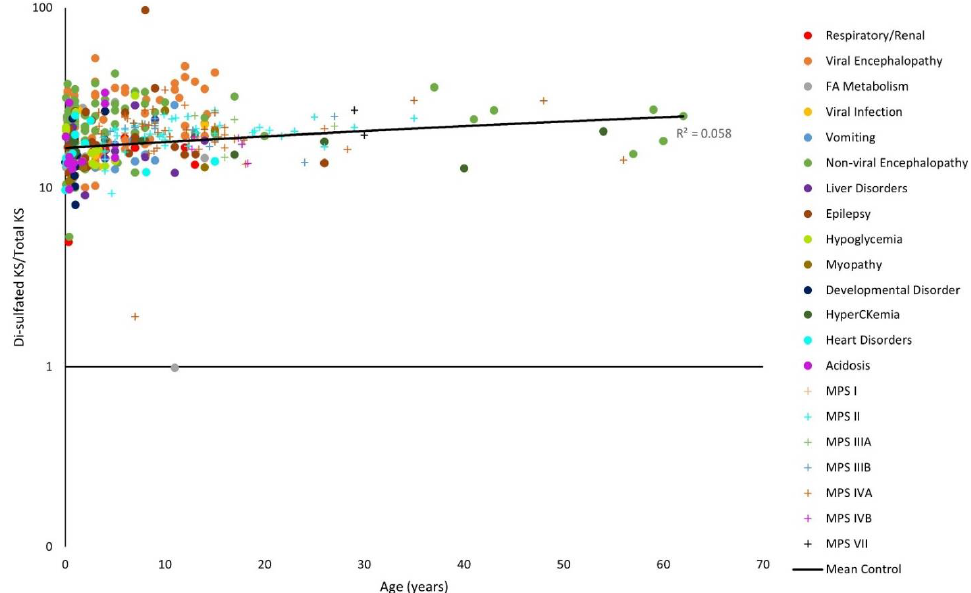
Figure 6. Ratio of di-sulfated keratan sulfate (KS) to total KS levels with age on a logarithmic scale. The linear trendline of control values is shown as a black line, and glycosaminoglycan (GAG) values for patients with mucopolysaccharidosis (MPS) are shown as plus marks.